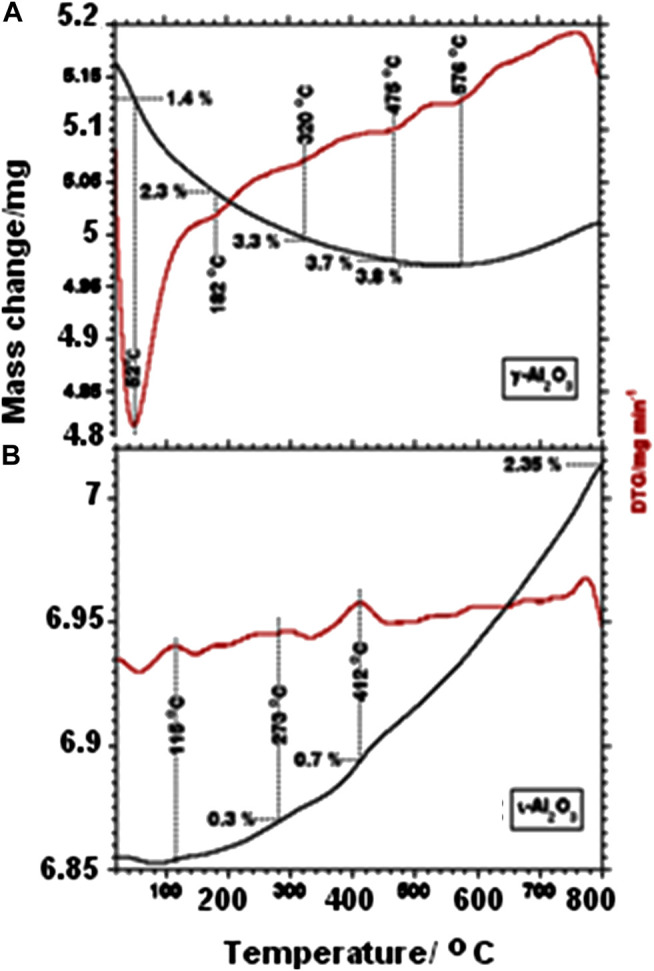
TG and DTG curves obtained for γ-Al2O3
(A) and ι-Al2O3
(B) while being heated at 10°C/min in 50 cm3 air/min.